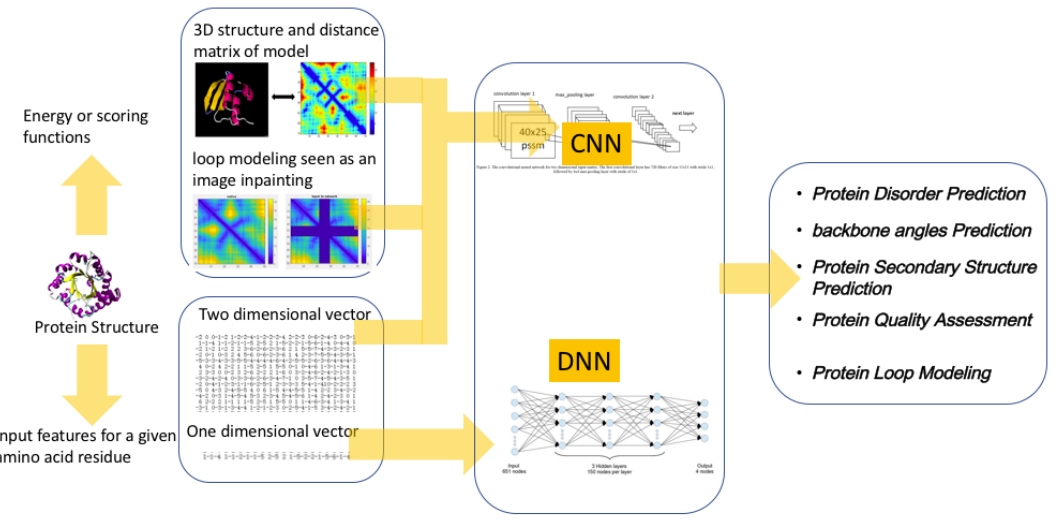
Figure 9. Protein Structure Prediction